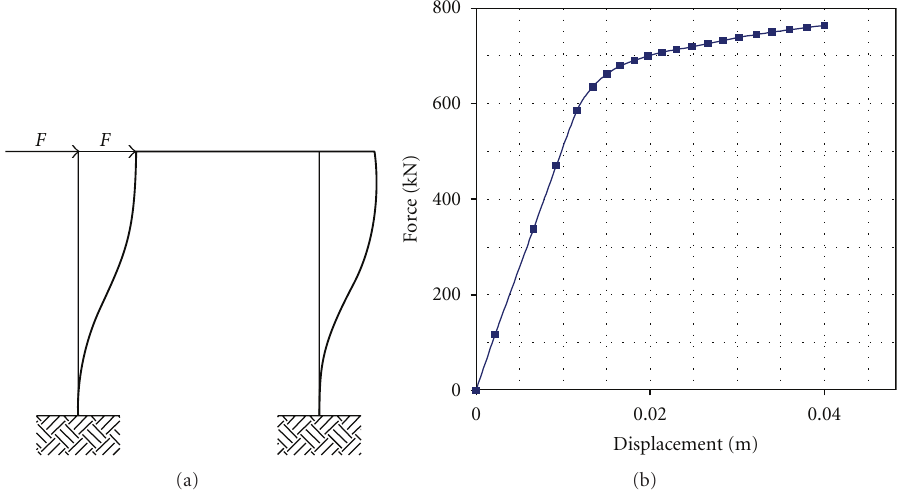
Figure 8: (a) Piers behaviour in the transverse direction: deflection shape; (b) force-displacement curve.